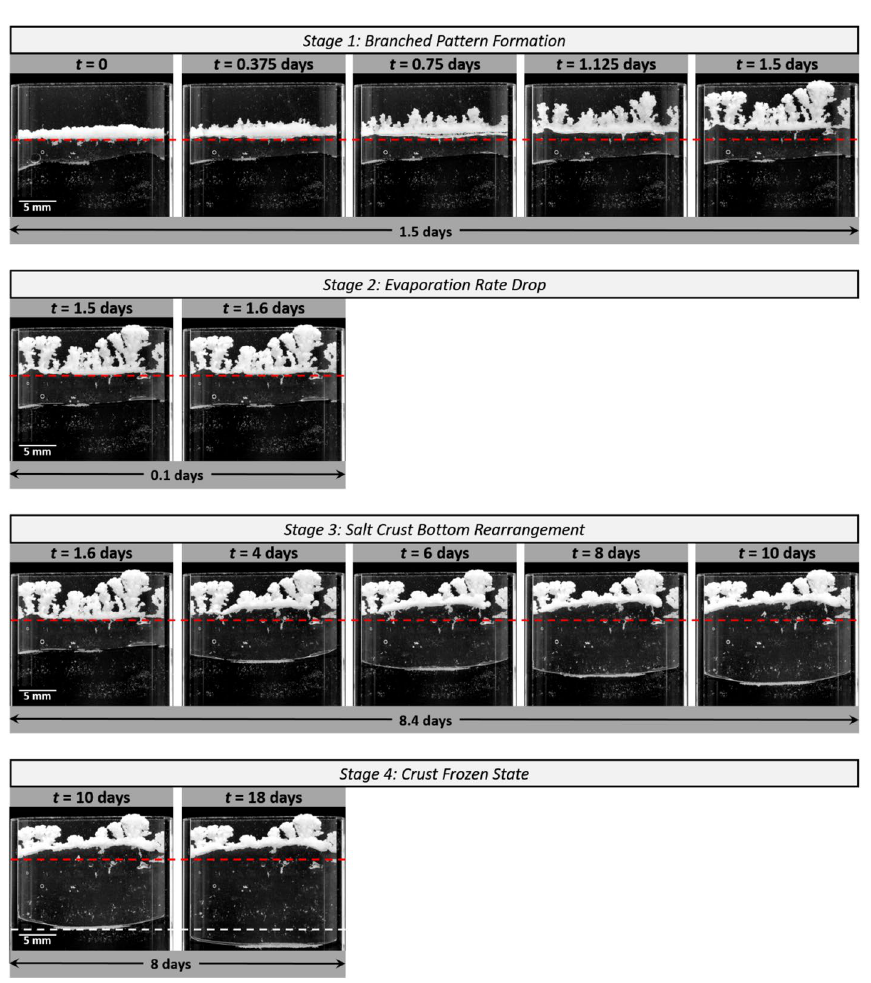
Figure 2. Pictures of the salt crust in the Hele-Shaw cell. Illustration of the various stages in the evolution of the crust identified from both the crust morphology modification and evaporation rate variation. The red horizontal dashed lines are guide to the eye to see better the crust evolution and its upward migration. The white objects on the liquid–gas interface or attached to the walls (more visible in the supplementary movies) correspond to residual glass